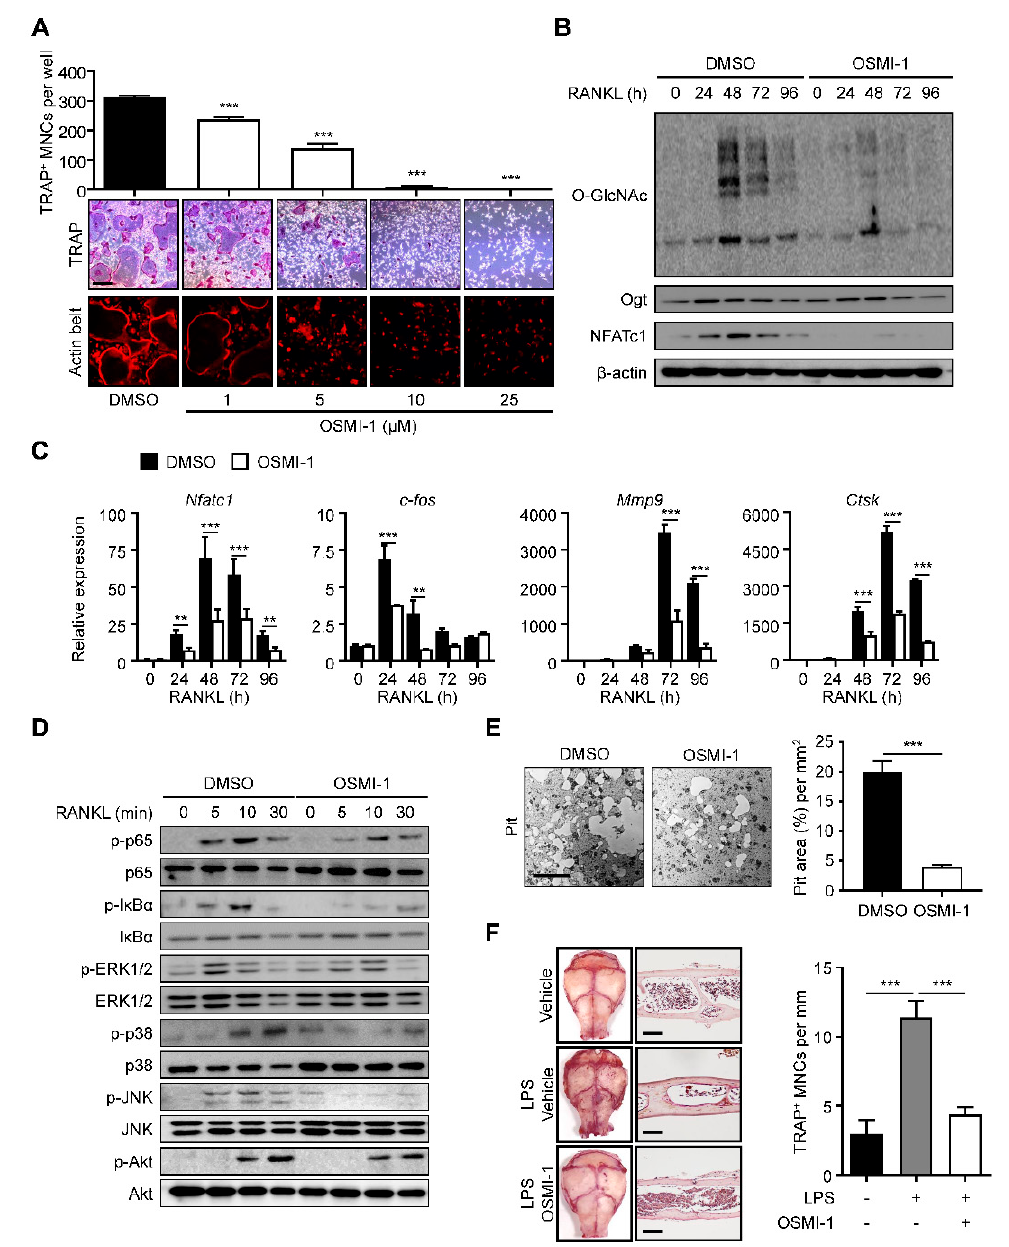
Figure 2. OSMI-1 inhibits RANKL-mediated osteoclastogenesis. ( A ) BMMs were incubated with M-CSF (30 ng/mL) and RANKL (100 ng/mL) in the absence or presence of OSMI-1. After 4 days, the TRAP-specific mature osteoclasts and actin belt formation were decreased by OSMI-1 in a dose-dependent manner. Scale bar, 200 µ m. ( B ) The global O-GlcNAcylation, Ogt, and NFATc1 levels were measured by Western blot analysis. The global O-GlcNAcylated protein and NFATc1 expression levels were inhibited by 5 µ M OSMI-1. ( C ) Relative mRNA expression levels of osteoclast markers, as measured by RT-qPCR. The mRNA ex-pression levels were decreased by 5 µ M OSMI-1 during osteoclast differentiation. ( D ) Relative phosphorylation levels of the RANKL-stimulated activating signaling, as measured by Western blot analysis. ( E ) BMMs were placed on calcium-phosphate-coated plates and cultured with M-CSF (30 ng/mL) and RANKL (100 ng/mL) in the absence or presence of 5 µ M OSMI-1. After 96 h, bone-resorbed areas were quantified. Scale bar, 100 µ m. ( F ) Representative images of TRAP-stained surfaces and sections of calvaria tissue in a vehicle or 10 mg/kg/day OSMI-1-treated mice, into which 25 mg/kg LPS was injected. The number of TRAP-specific mature osteoclasts from stained calvaria tissue samples (left panel). Scale bar, 100 µ m. Statistical data are presented as the means ± S.E.M. (** p < 0.01 and *** p < 0.001, as measured by Student’s t -test).